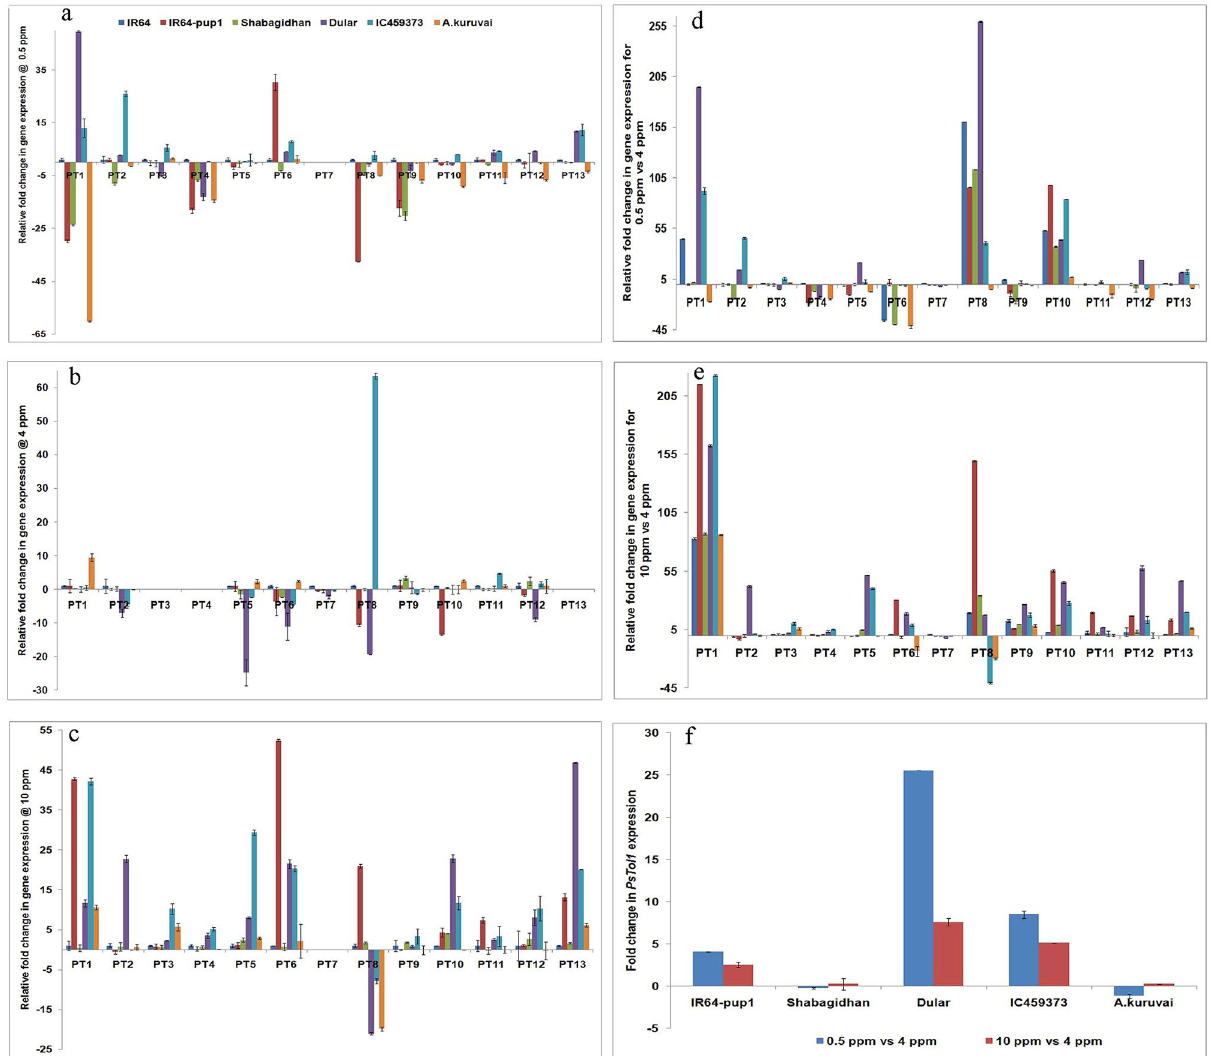
Figure 7. Expression analysis of PSTOL1 and OsPT genes in rice in different concentrations of P. ( a ) Relative fold change in expression of OsPT genes between the genotypes in 0.5 ppm of P concentration, ( b ) relative fold change in expression of OsPT genes between the genotypes in 4.0 ppm of P concentration, ( c ) relative fold change in expression of OsPT genes between the genotypes in 10.0 ppm of P concentration, ( d ) relative fold change in expression of OsPT genes from 0.5 ppm to 4.0 ppm of P concentration, ( e ) relative fold change in expression of OsPT genes between 10.0 ppm and 4.0 ppm of P concentration, and ( f ) fold change in expression of PSTOL1 between 0.5 ppm and 4.0 ppm and 100 ppm and 4.0 ppm of P